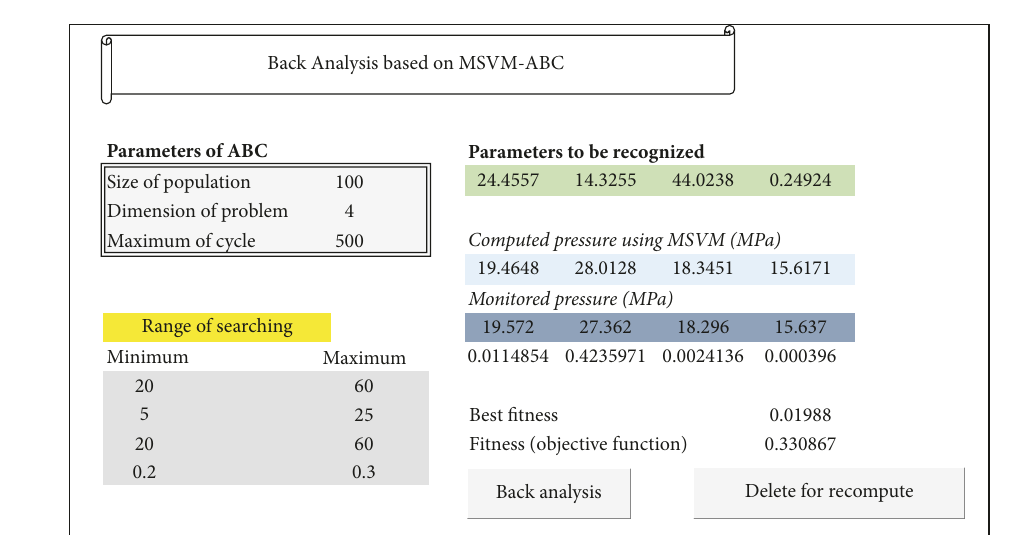
Figure 3: Comparison of pressure data estimated by MSVM and borehole measured data.